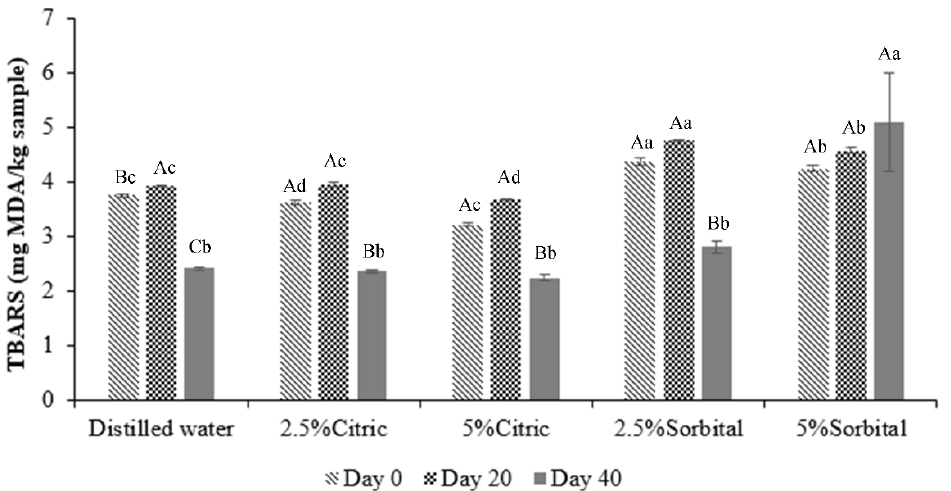
Figure 2. Thiobarbituric-acid-reactive substances (TBARS) of frozen fish fillet soaked with different solutions storage during frozen storage times. Different small superscript letters on the bar are significantly different ( p < 0.05) with respect to the treatment. Different capital superscript letters on the bar are significantly different ( p < 0.05) with respect to the period of storage. The results are reported as mean ± SD (n = 3).